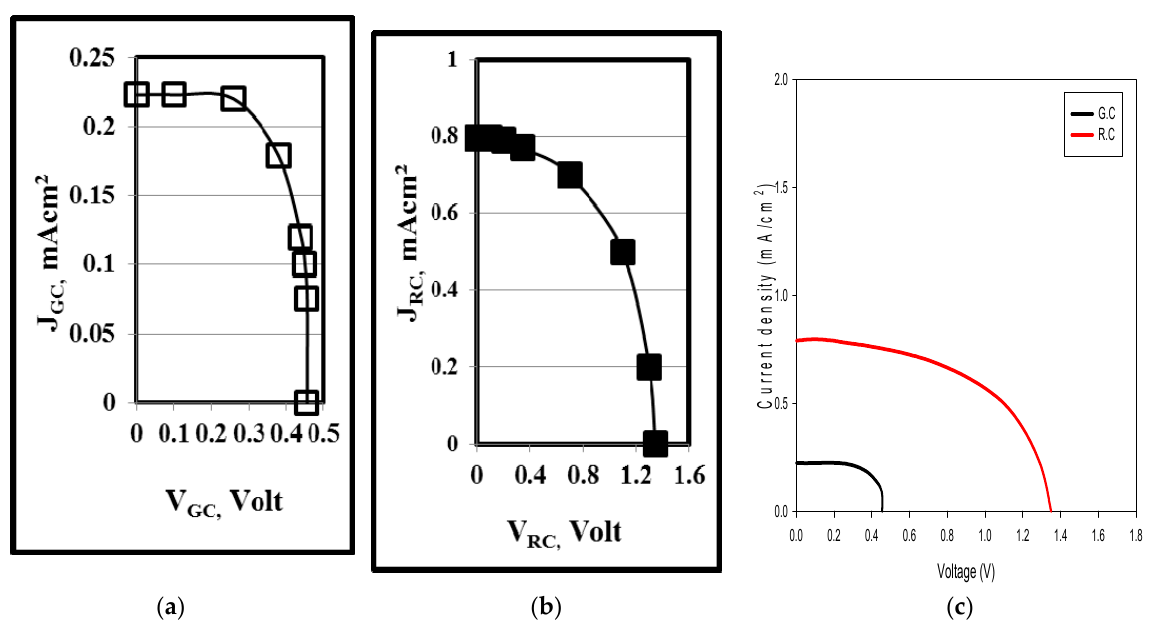
Figure 9. J/V relation of Green cabbage and Red cabbage, ( a ) J/V GC, ( b ) J/V RC, and ( c ) J/V Rc and GC. Cells